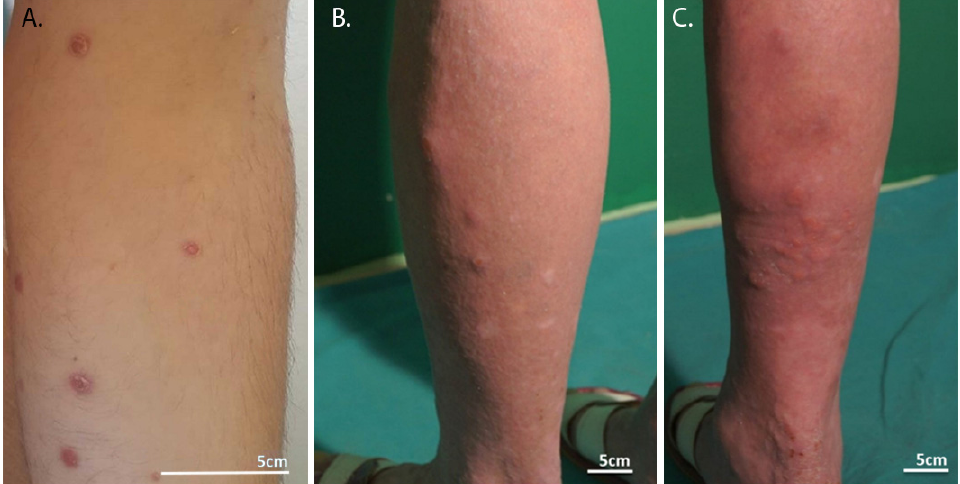
Figure 1. Skin lesions in lymphomatoid papulosis. ( A ) Widespread erythematous papulonodular eruptions with scaling of the lesions (reproduced from Kavvalou et al. [45]). ( B ) Typical manifestation of lymphoid clumps (authors’ archive). ( C ) Typical manifestation with clustered nodules on the patient’s skin (authors’ archive).